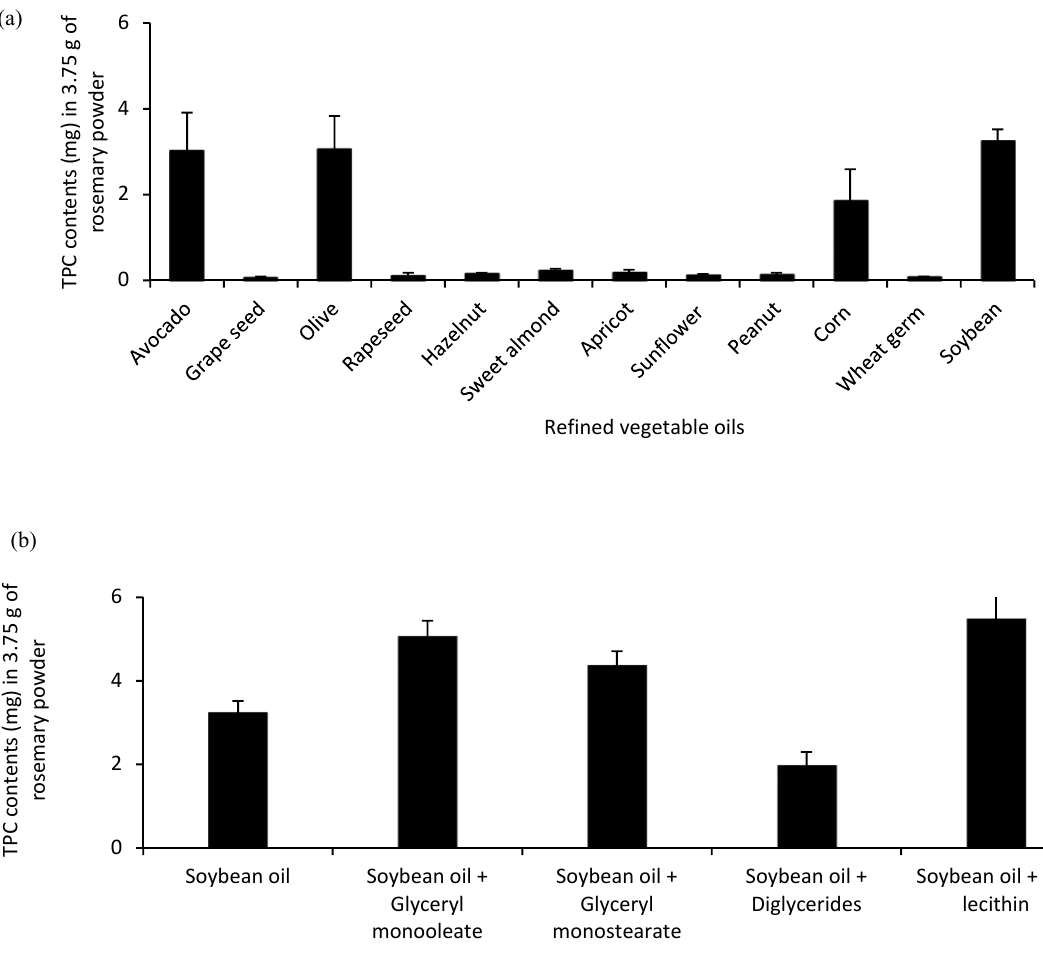
Figure 3. Total phenolic content (TPC) in rosemary oleo-extracts by using ( a ) refined vegetable oils and ( b ) refined soybean oil with the addition of oil derivatives as solvents.